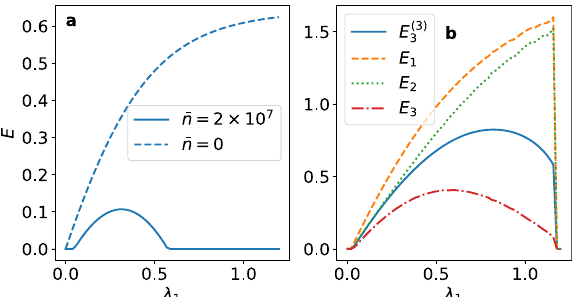
Fig. 5 Genuine tripartite entanglement with two particles per Bogoliubov mode. a Entanglement E ð 3 Þ optimized over symmetric 3 coupling G 1 = G 2 = G 3 in the presence of thermal noise ( n ¼ 2 ´ 10 7 , solid) and in its absence ( n ¼ 0 , dashed). b Entanglement E ð 3 Þ (solid 3 blue line) optimized over general coupling rates G 1 ≠ G 2 ≠ G 3 . The asymmetry in coupling the three Bogoliubov modes to the cavity fi elds results in unequal entanglement in the three bipartitions as shown by plotting the corresponding logarithmic negativities E 1,2,3 . System parameters are the same as in Fig.